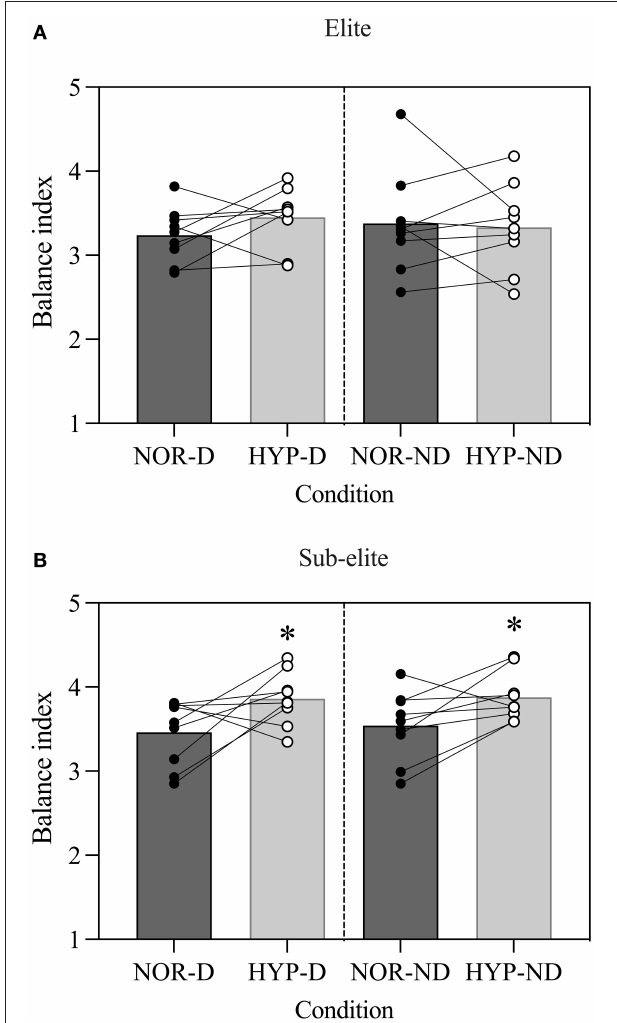
FIGURE 2 | Acute effects of normobaric hypoxia on a single leg balance test performance in (A) elite and (B) sub-elite basketball players. NOR, normoxic condition; HYP, normobaric hypoxic condition; D, dominant leg; ND, non-dominant leg. *Values significantly different from those obtained in NOR; P <